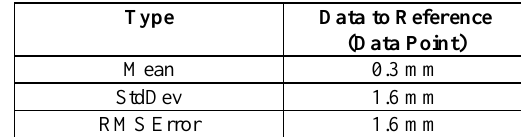
Table 5 Deviation statistics between NextEngine and Iwitness Model